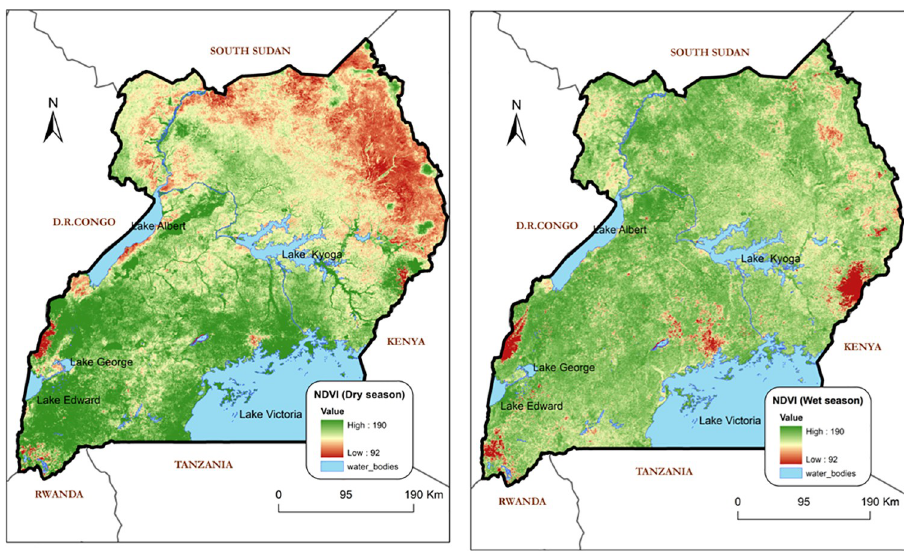
Fig 3. Normalised Difference Vegetation Index as predictor variable for the model. This NDVI map was processed using ArcGIS 9.1 based on data from